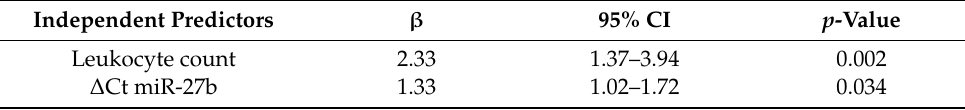
Table 4. Parameters dysregulated in active smokers in multivariate logistic regression analysis.